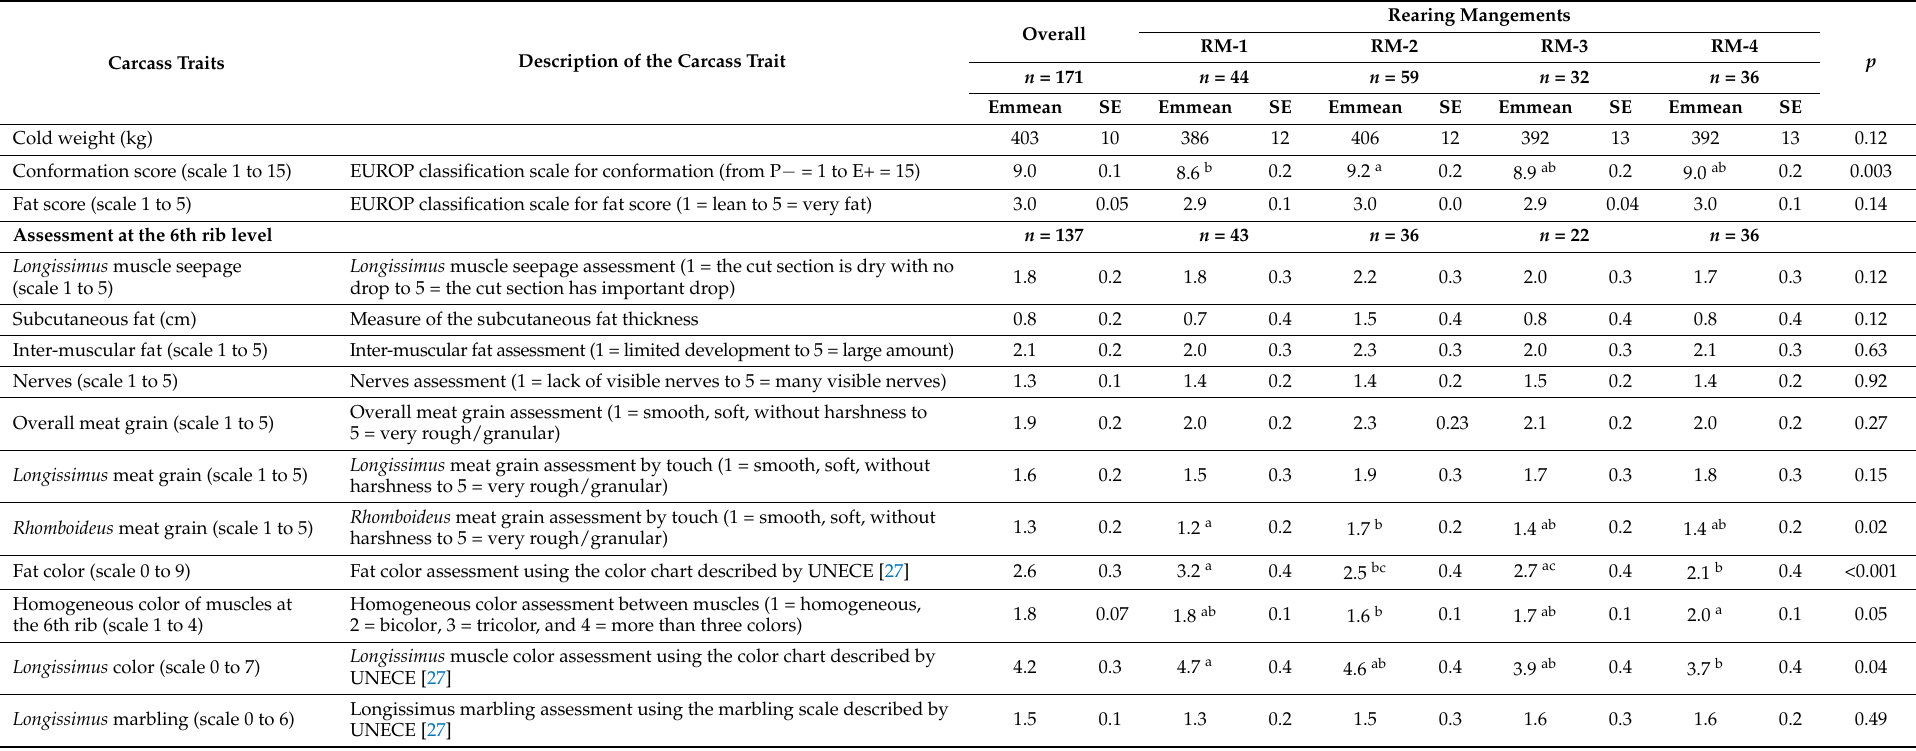
Table 4. Effects of the four rearing managements (RM) applied during the whole heifers’ life factors on the carcass